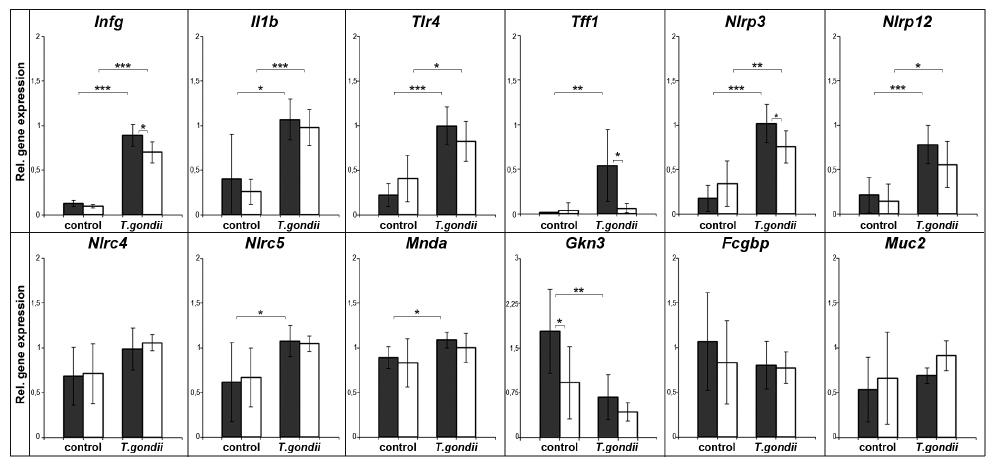
Figure 2. Semiquantitative RT-PCR analyses. Ifng (30 × ), Il1b (27 × ), Tlr4 (32 × ), Tff1 (32 × ), Nlrp3 (33 × ), Nlrp12 (35 × ), Nlrc4 (33 × ), Nlrc5 (33 × ), Mnda (33 × ), Gkn3 (35 × ), Fcgbp (35 × ), and Muc2 (35 × ) expression was monitored in the spleen four weeks after i.p. T. gondii infection (encephalitis model; six wild type and six Tff1 KO mice, respectively). As a control, the spleen of non-infected animals (six wild type and six Tff1 KO mice, respectively) was investigated. The relative gene expression levels were normalized against β -actin ( Actb , 22 × ). The number of amplification cycles is given in parentheses. Significances are indicated by asterisks (*, p ≤ 0.05; **, p ≤ 0.01; ***, p ≤ 0.001). Wild type animals: black bars; Tff1 KO animals: white bars.